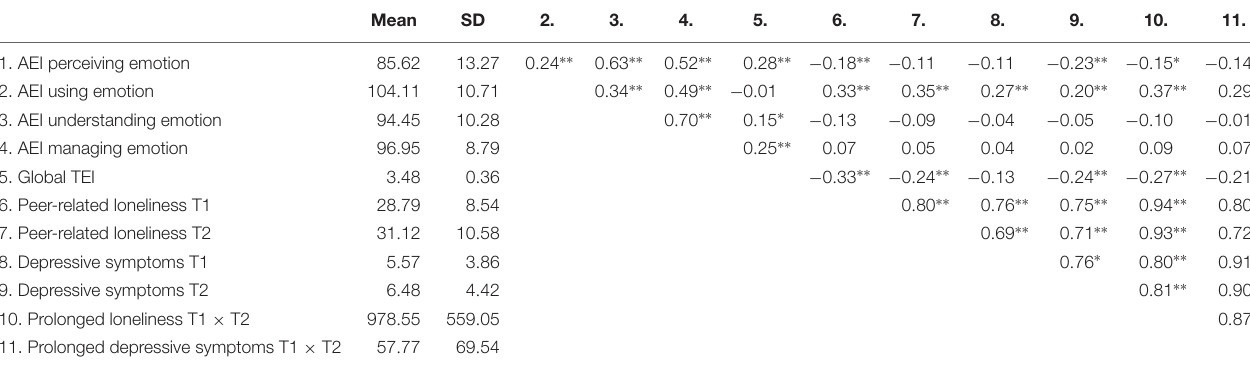
TABLE 1 | Means and standard deviations with bivariate associations.